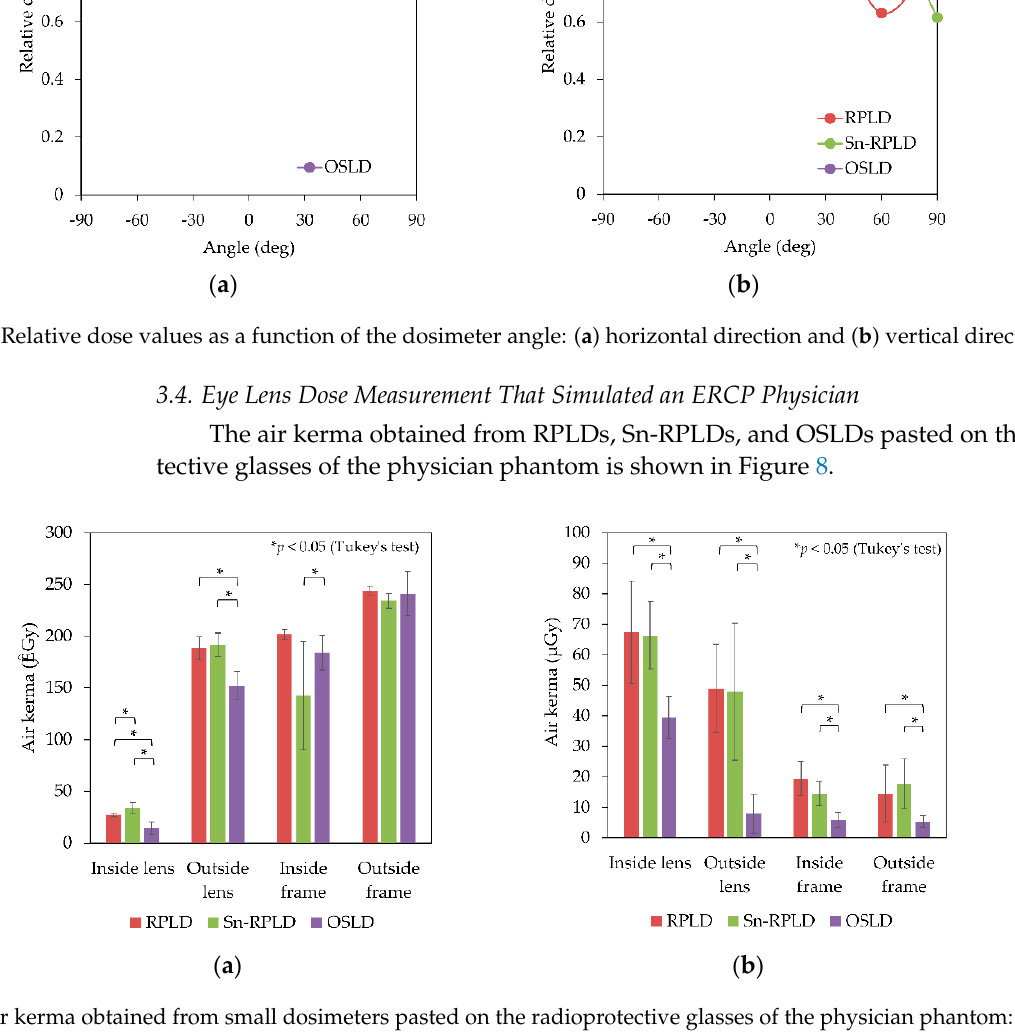
Figure 8. Air kerma obtained from small dosimeters pasted on the radioprotective glasses of the physician phantom: ( a ) left side and ( b ) right side.